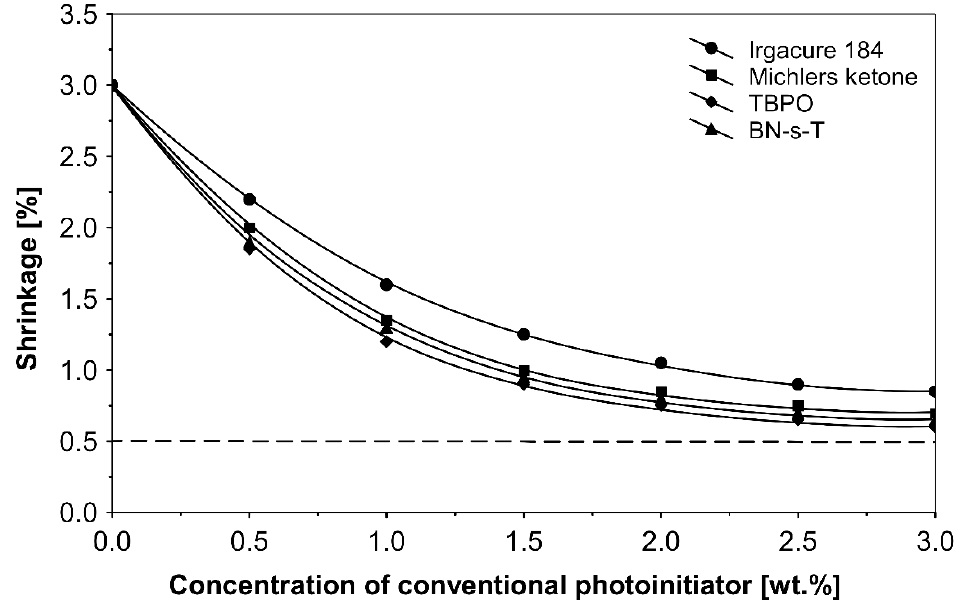
Figure 4. Shrinkage of the acrylic PSAs containing selected conventional saturated photoinitiators after the UV crosslinking using a UV